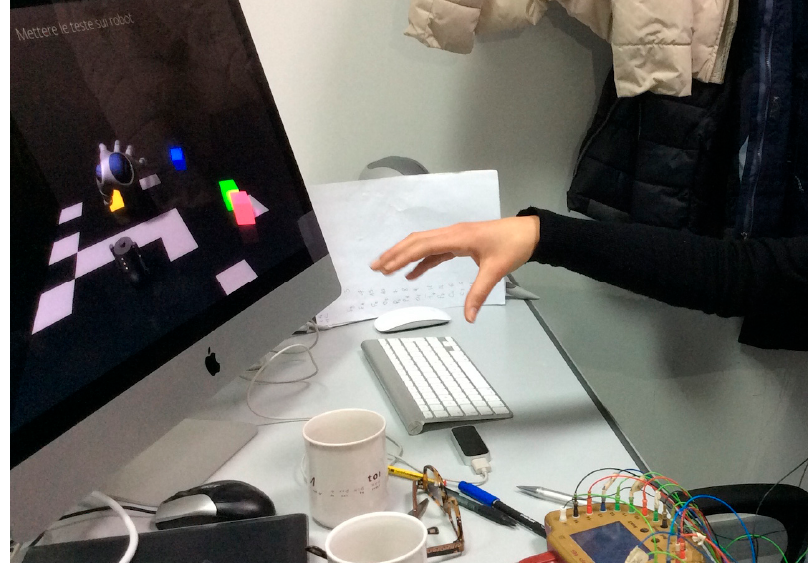
Figure 1. The use of Leap Motion controller during the experiments.